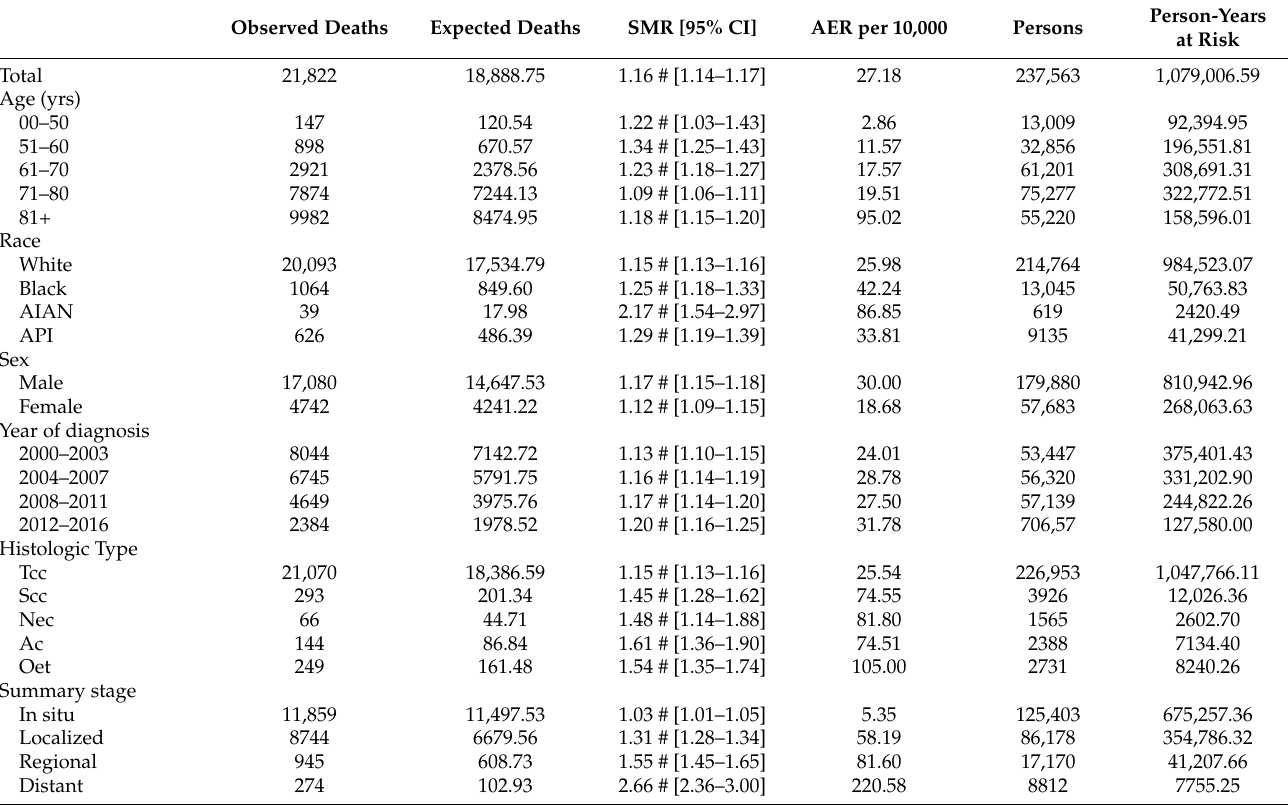
Table 1. Baseline features and standardized mortality ratios of cardiovascular mortality in patients with bladder cancer.